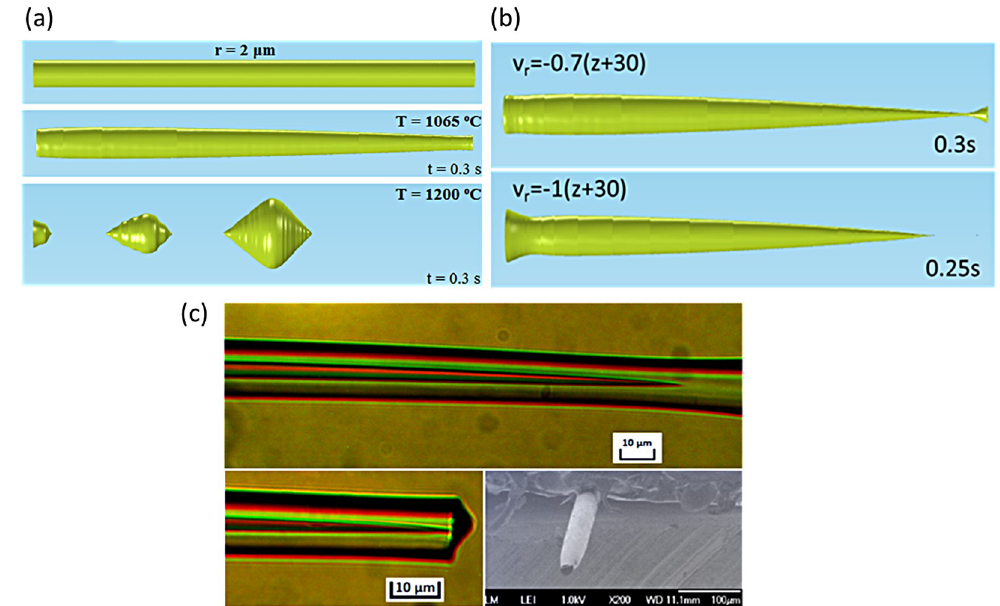
Figure 10. ( a ) Simulation of the tapering process of a 2 µ m core radius microfiber at 1065 ◦ C and 1200 ◦ C with v r = − 0.5 (z + 30) ( µ m / s), showing the core’s evolution after 0.3 s. ( b ) Simulation of the tapering process of a 2 µ m core radius microfiber at 1065 ◦ C for higher radial velocities. ( c ) Top: Optical microscope images of a fabricated fiber tip before cleaving. Bottom: Optical microscope (left) and SEM (right) characteristic images of a fabricated fiber tip after the cleaving process (Reprinted with permission from [6]. Copyright 2018 American Chemical Society).